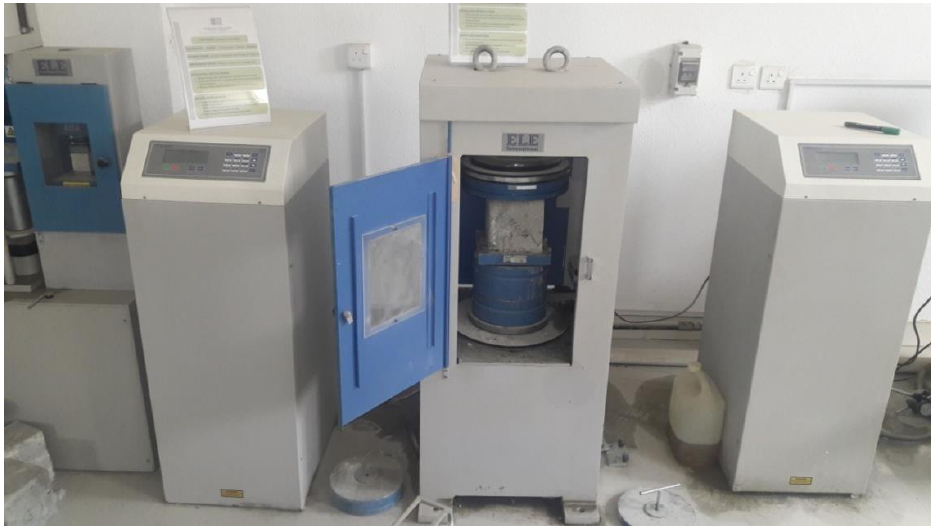
Figure 5. Compressive stress test setup.